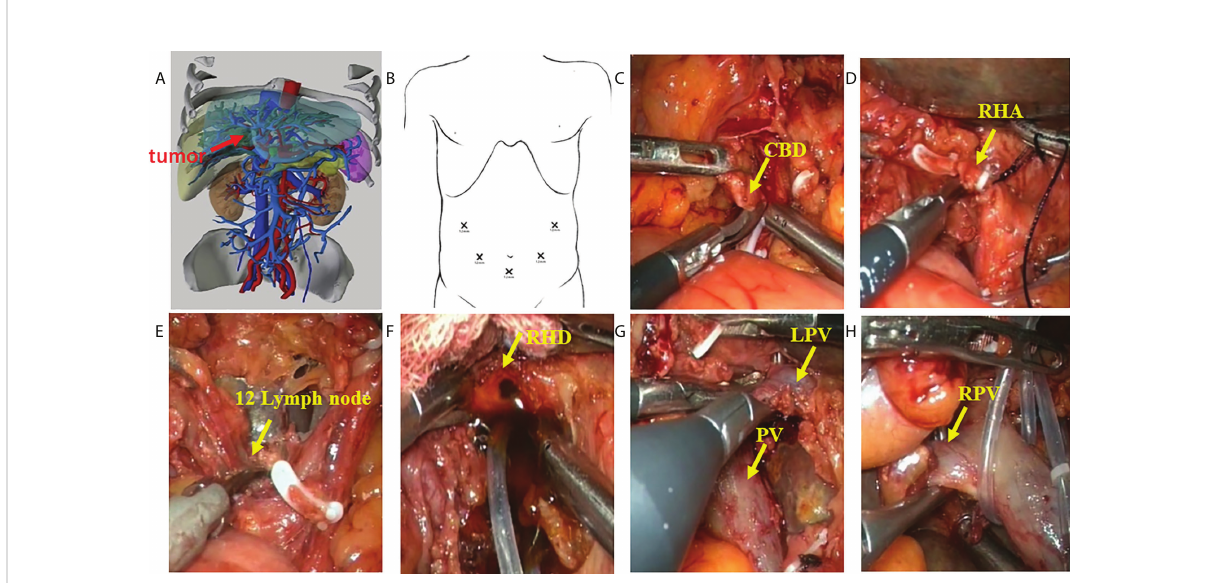
FIGURE 2 Procedure of laparoscopic hilar cholangiocrinoma 1. (A) three-dimensional (3D) imaging of the tumor (red arrow); (B) Trocar placement during laparoscopic radical resection for HCCA. The chief operator stands on the right side of the patient, inserting 5-mm and 12-mm trocars into the right abdomen; the fi rst assistant stands on the patient ’ s left side, placing 5-mm and 12-mm trocars above the umbilicus and on the left abdomen; and the camera-holder stands between the two legs of the patient(yellow arrow). (C) sever the lower end of the common bile duct at the upper border of the pancreas; (D) transect the right hepatic artery(yellow arrow); (E) dissect the lymph nodes in the hilar region(yellow arrow); (F) transect the right hepatic duct(yellow arrow); (G) identify the left branch of portal vein and portal vein (yellow arrow); (H) identify the right branch of portal vein (yellow arrow). CBD, Common bile duct; RHA, Right hepatic artery; RHD, Right hepatic duct; LPV, Left branch of portal vein; PV, Portal vein; RPV, Right branch of portal